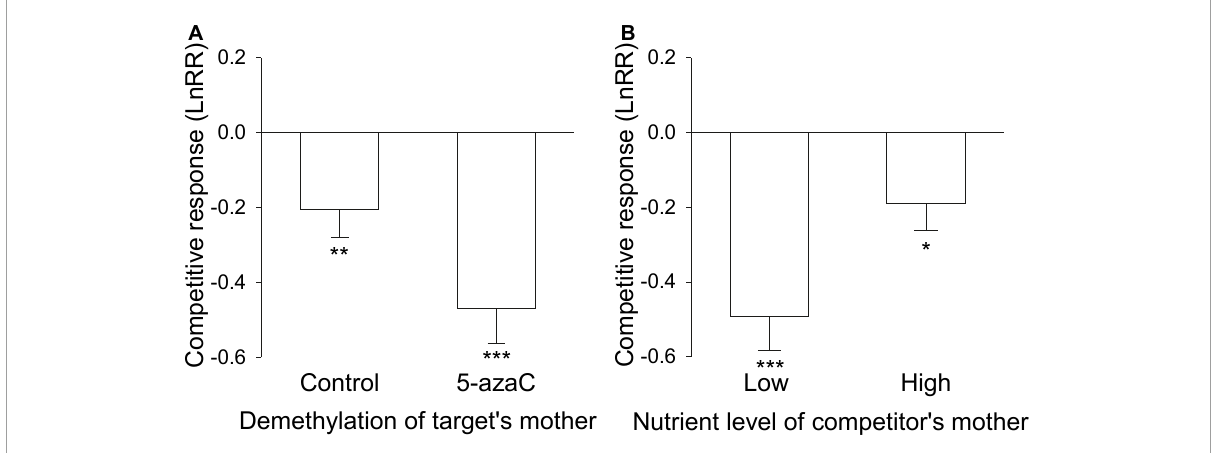
FIGURE3 (A) The effect of DNA demethylation of the target’s mother and (B) the effect of the nutrient level of the competitor’s mother on the competitive response of the target plant of Pistia stratiotes . Bars show means + SE. Symbols (*** P < 0.001; ** P < 0.01; * P < 0.05) indicate significant difference from zero (by one-sample t